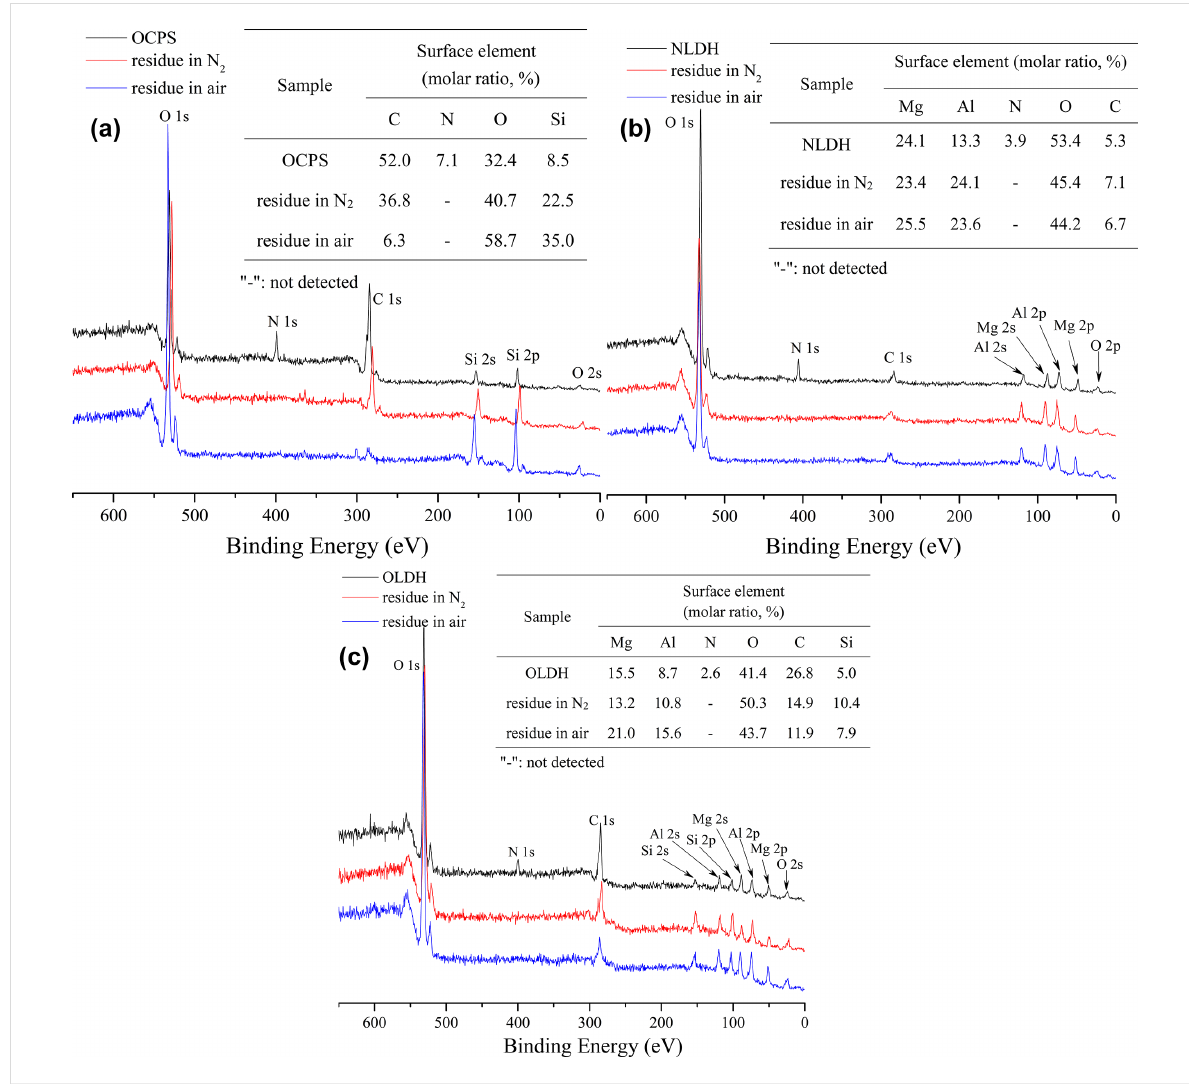
Figure 13: XPS measurements of surface components before and after thermal degradation of (a) OCPS, (b) NLDH and (c) OLDH).